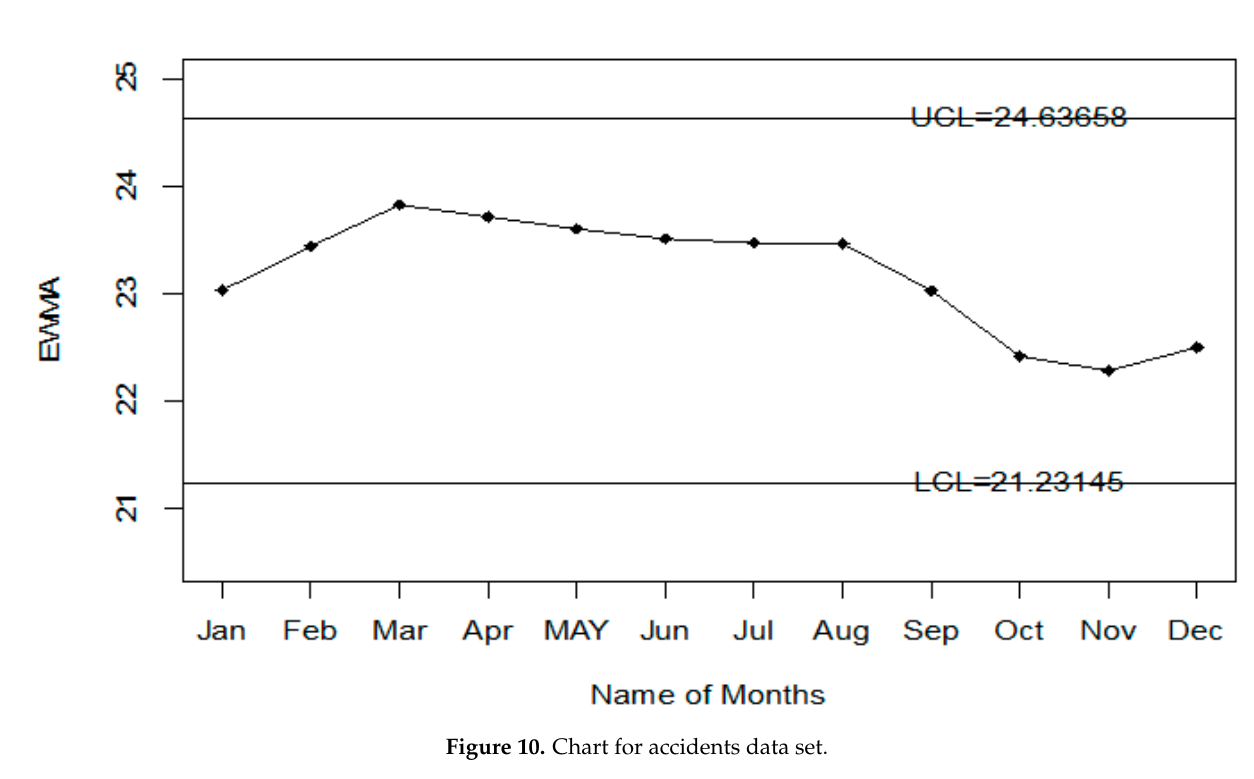
Figure 10. chart for accidents data set. Figure 10. Chart for accidents data